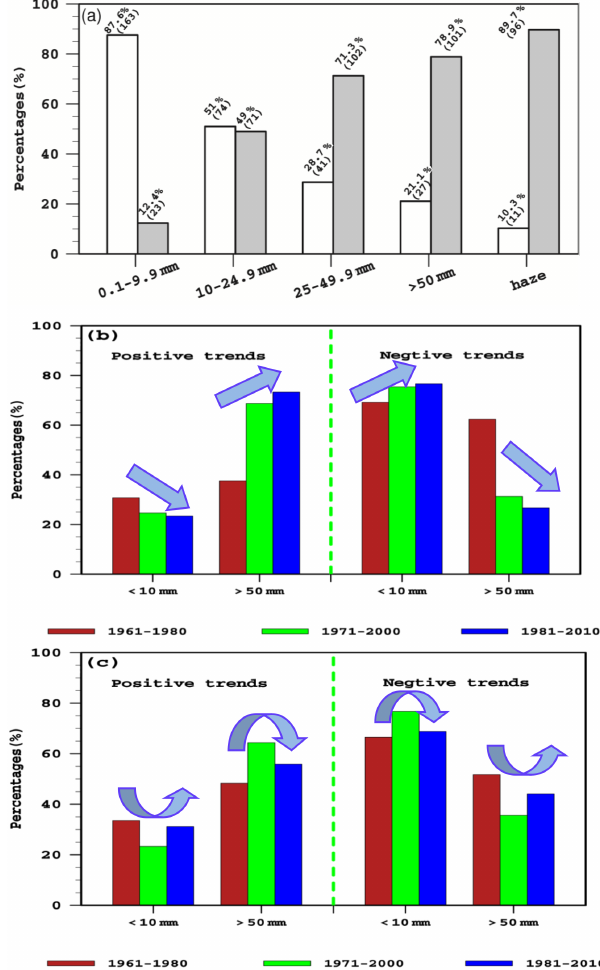
Figure 6. (a) Percentages of stations with positive and negative trends in number of day in various precipitation grades from 1961 to 2010 over the EC stations. The percentages of sites with nega- tive frequency trends in light rain and positive trends in rainstorm events in total sites with positive (left side) and negative (right side) trends in haze over (b) the EC and (c) TP regions during the three interdecadal periods (1961–1980, 1971–2000 and 1981–2010). The arrows indicate the interdecadal change